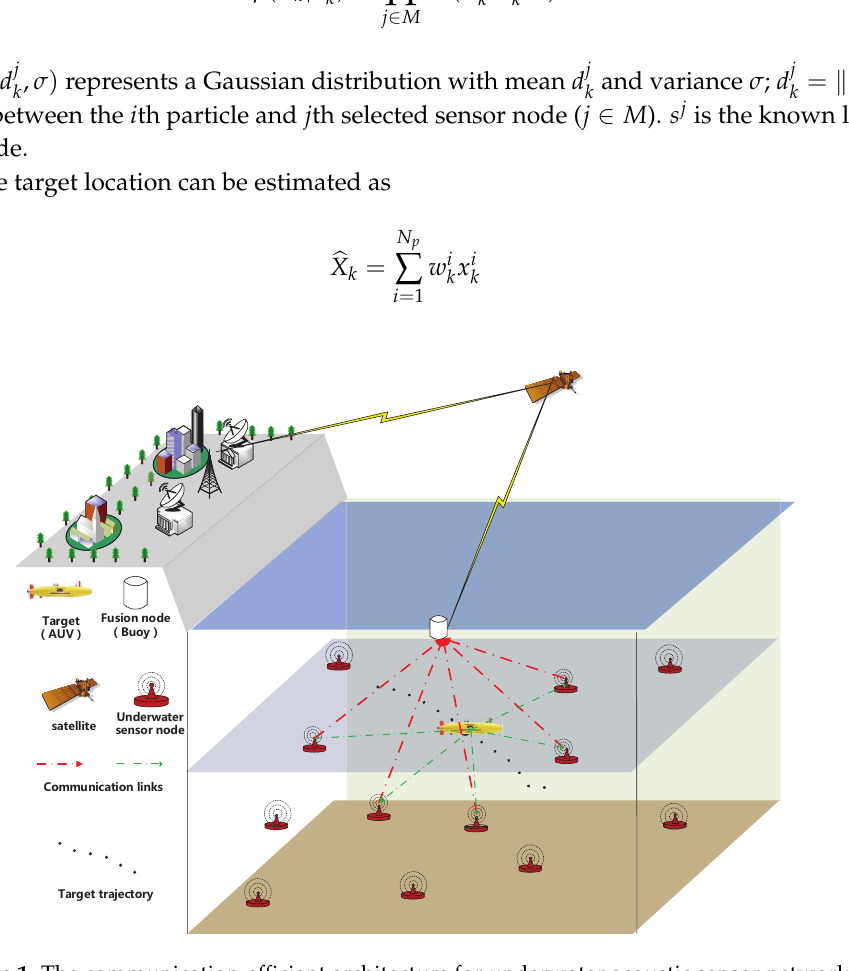
Figure 1. The communication-efficient architecture for underwater acoustic sensor